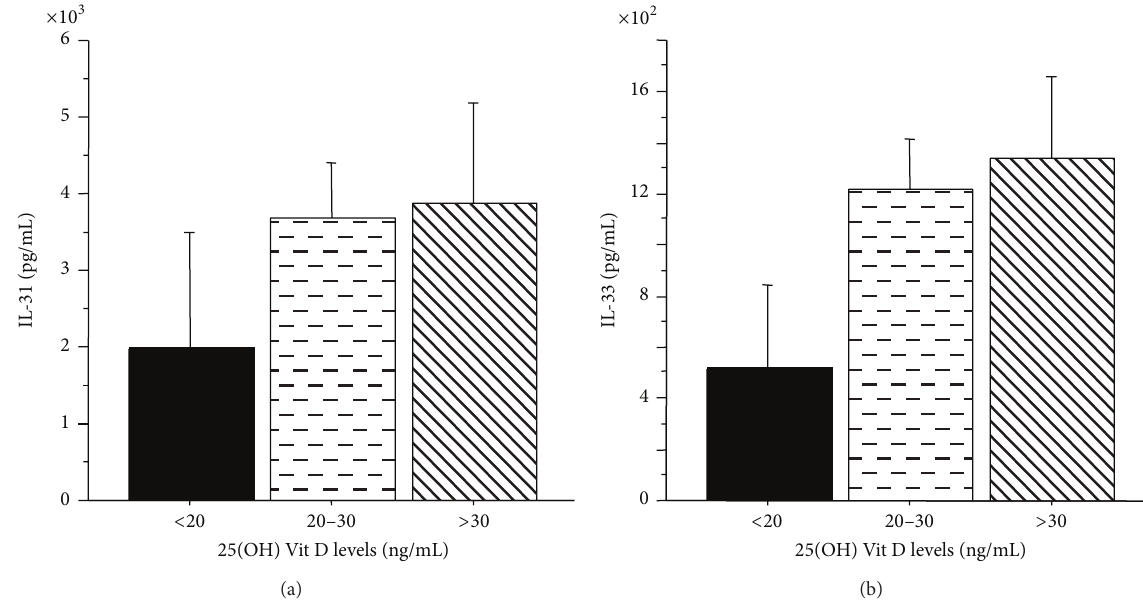
Figure 3: IL-31 and IL-33 plasma levels and 25(OH) Vit D status in patients with AAR ( 𝑛 = 35 ). (a) IL-31 concentrations and (b) IL-33 concentrations were measured by specific ELISA in AAR patients with deficient ( 𝑛 = 6 ), insufficient ( 𝑛 = 22 ), or sufficient ( 𝑛 = 7 ) 25(OH) Vit D levels. Bars represent mean ± SD. Statistical analysis was performed by Kruskal-Wallis test. Significance was accepted at 𝑃 < 0.05